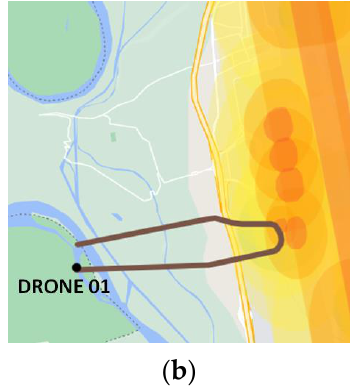
Figure 17. Instances of threat scenario classes. ( a ) “Threat on fingers”. ( b ) “Threat on tower”.